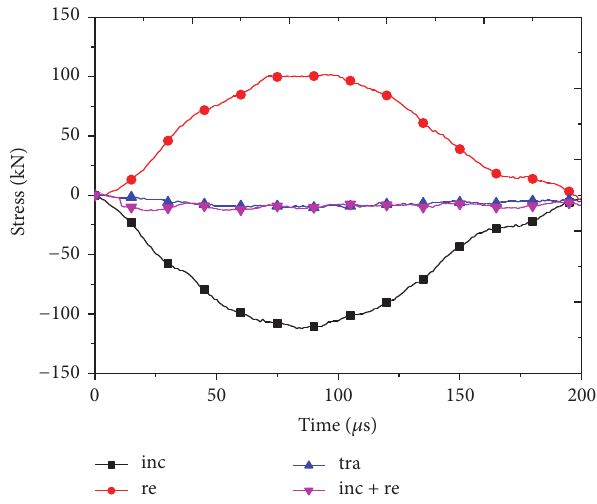
Figure 4: Dynamic force balance check for a typical